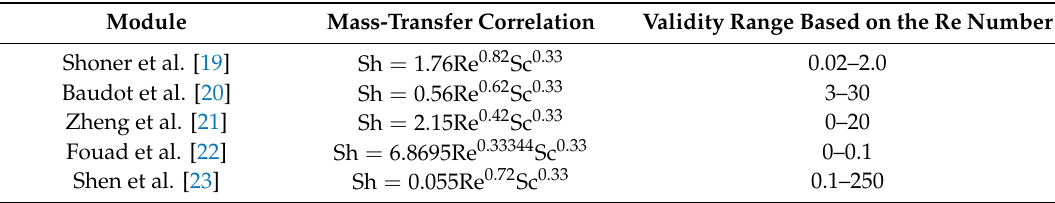
Table 4. Mass-transfer correlations reported in previous studies for the 2.5 × 8 Extra Flow.